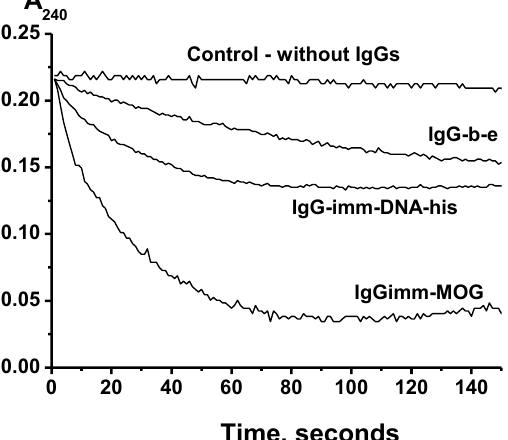
Figure 1. Typical examples of the time-dependences of H 2 O 2 decomposing in the presence of three different IgG preparations (0.1 mg/mL). All designations are given in the panel; IgG-b-e is one of preparations corresponding to the group of 3-month-old mice at the beginning of the experiment; IgG2-imm-DNA-his is one of the preparations corresponding to the group of mice immunized with the DNA–histone complex; IgG-imm-MOG corresponds to mice immunized with MOG (see below). Using the analysis of the activities of IgGs in the hydrolysis of DNA, MBP, MOG, and histones, as well as the peroxidase oxidation of DAB and ABTS after the SDS-PAGE of the antibodies, it was shown that all of these activities are properties of IgGs [10,11,40–42]. To prove that the catalase activity belongs directly to the antibodies and not to any admixtures of canonical catalases, we used an equimolar mixture of 21 IgG preparations (IgG mix ). After the SDS-PAGE and removal of SDS, the gel was cut into small fragments, and all components of these fragments were eluted from the gel. The eluates of the gel fragments were used to analyze the contents of proteins capable of decomposing hydrogen peroxide (Figure 2). The catalase activity was detected only in the gel fragments corresponding to 150 kDa IgG mix . Since SDS dissociates all protein complexes, seeing the catalase activity only in the gel fragment of intact IgG mix and the absence of any other protein bands